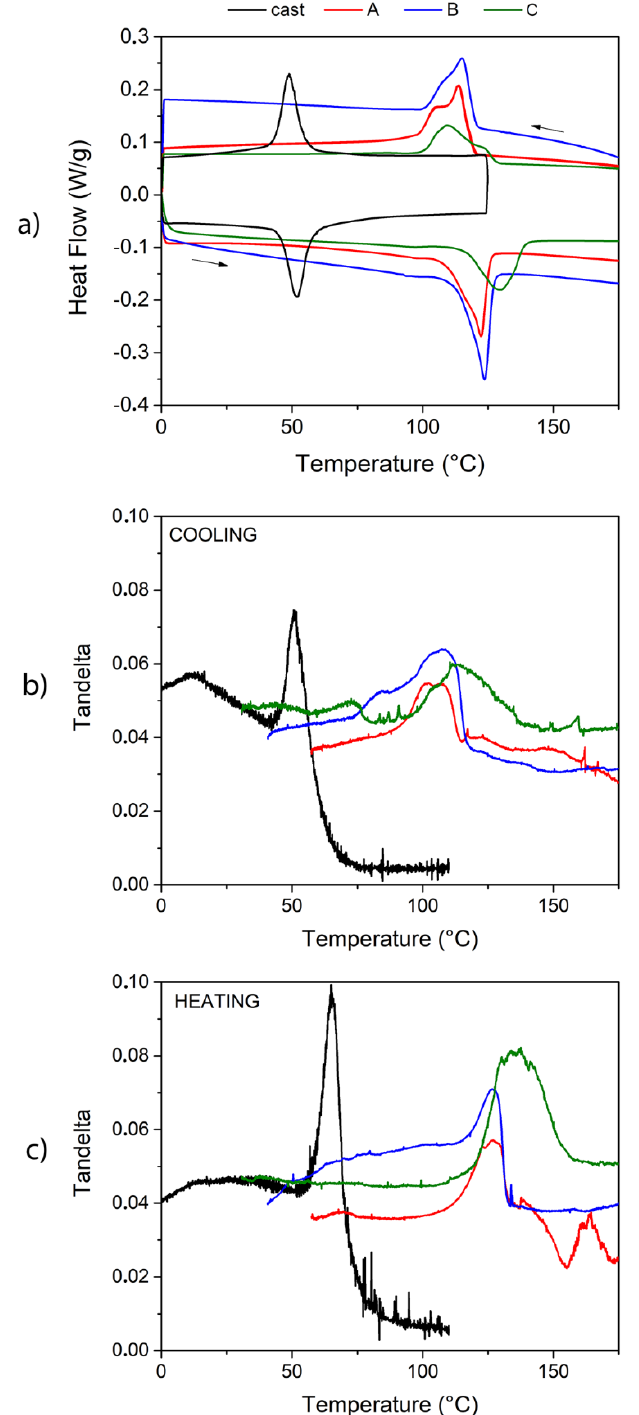
Figure 5. DSC analysis results ( a ) and DMTA curves vs. temperature in heating ( b ) and cooling stage ( c ) for the investigated samples.